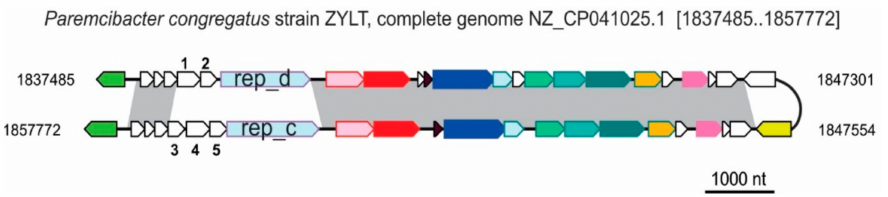
Figure 6. Replacement of a replication protein gene in closely related prophages. Two closely related prophages from the Paremcibacter congregatus genome are aligned; regions with more than 90% identi- cal nucleotides are connected by gray shaded shapes. Genes are colored as on Figure 3. Five numbered genes are: 1, NZ_CP041025_15; 2, NZ_CP041025_16; 3, NZ_CP041025_51; 4, NZ_CP041025_50; 5, NZ_CP041025_49 (Supplementary File